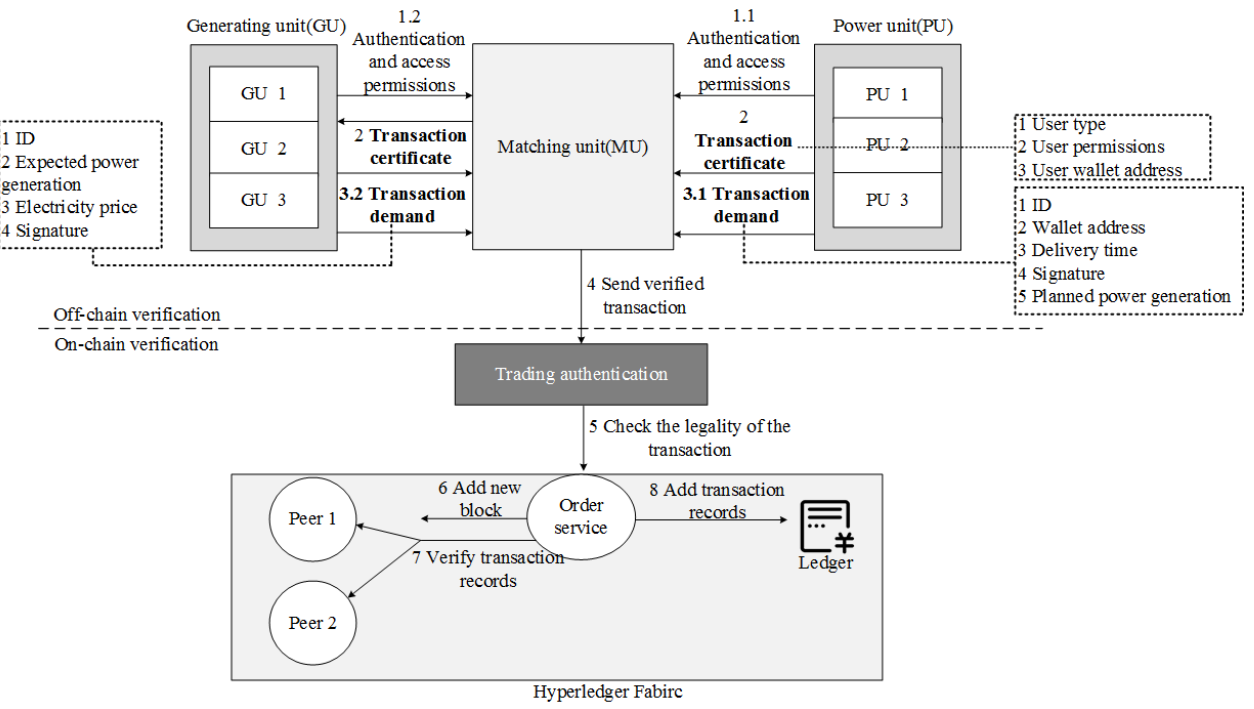
Figure 49. Reconstruction diagram of reference [83].